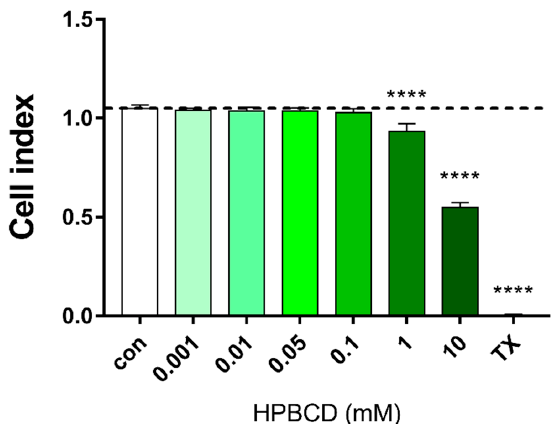
Figure 4. Effect of 2 h treatment with HPBCD on the viability of hCMEC/D3 cells. Values presented are means ± SEM. Statistical analysis: one-way analysis of variance followed by Dunnett’s post-test. **** p < 0.0001 compared to control group, n = 4 (except in case of 0.05 and 0.01 groups, where n = 3).